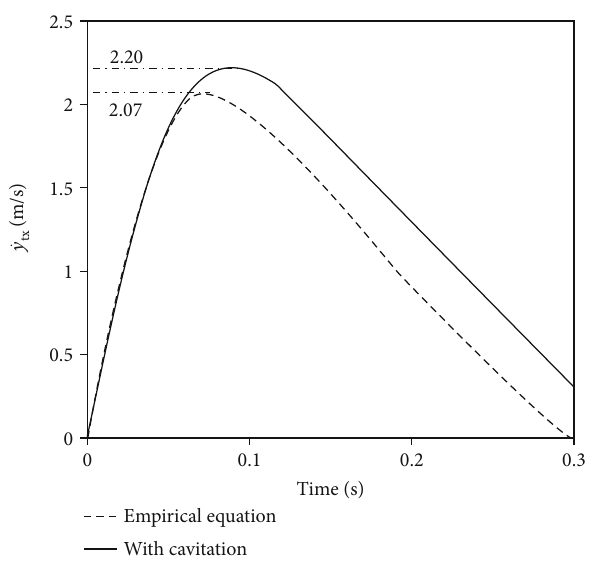
Figure 10: Comparison of vertical displacement of spring support